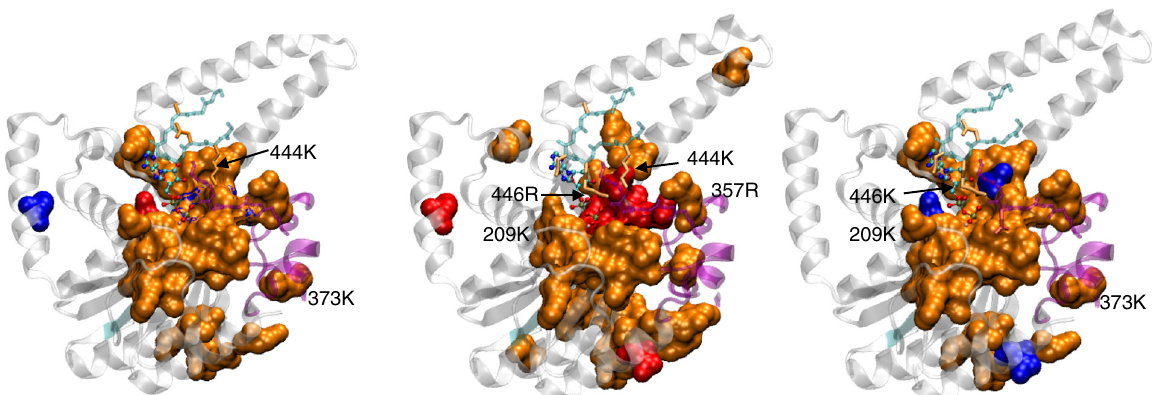
Fig. 5 Site-speci fi cally identi fi ed conformational change. a Details of conformational changes during ATP hydrolysis between the pre-hydrolytic state using AMP-PCP and the transition state mimicked by ADP:AlF 4 − , the left subpanel shows only the changing residues (see Legend box), the right subpanel in addition the unaffected residues; b changes upon DNA binding to the ADP:AlF 4 − bound state; and c changes during DNA translocation (ADP:DNA → AMP- PCP:DNA → ADP:AlF 4 − :DNA → ADP:DNA). The changes occurring at each arrow are shown in the three panels of c . The molecular structure shown represents a model in which the ADP is added based on homology with the Aa DnaB:ADP X-ray structure (pdb accession code 4NMN)